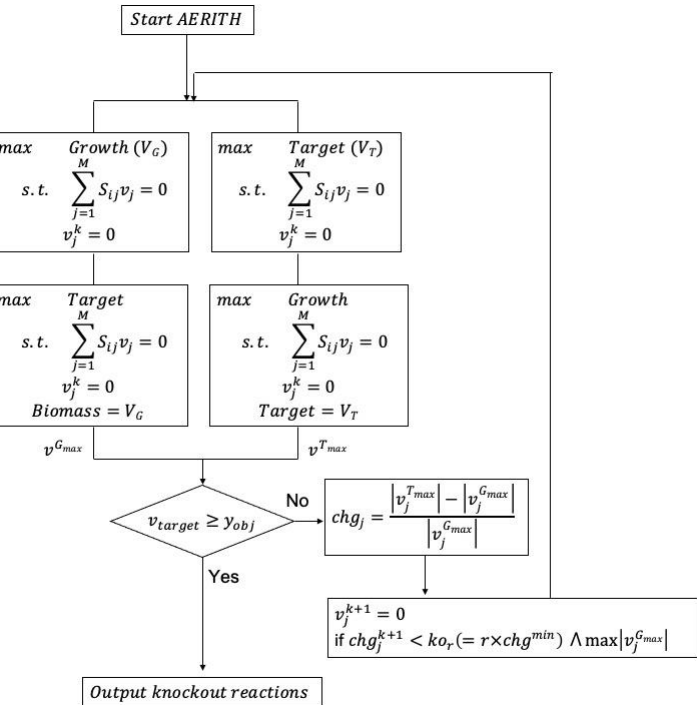
Figure 1. AERITH algorithm for target compound production. The objective function was set to maximize biomass growth and target compound, and two types of FBAs were performed. The value of chg was calculated for each calculated flux, after which the next deletion candidate was selected. v jk represents the kth deletion reaction and was added as a constraint to the FBA. y ob j represents the minimum production flux of the allowed target